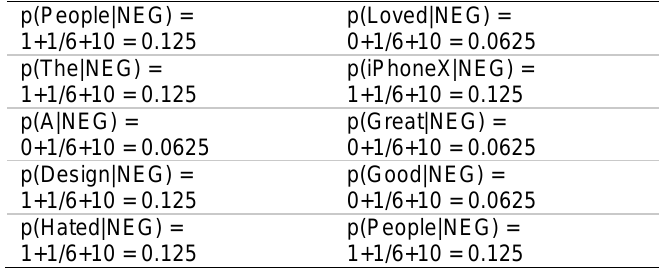
Figure 6. Snapshot of results of most informative features and accuracy (At the